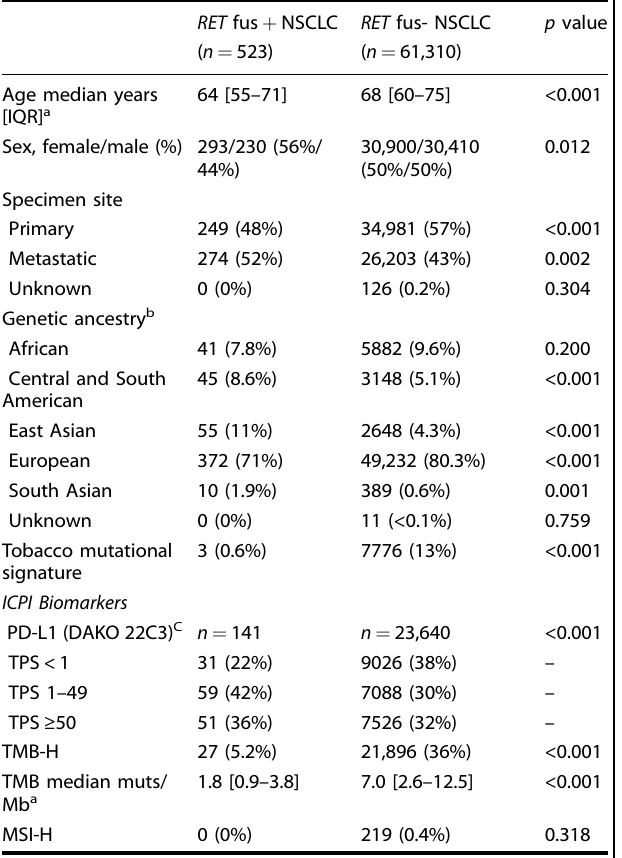
Table 2. Clinicopathologic and genomic biomarker characteristics comparing RET fusion-positive NSCLC and RET fusion-negative NSCLC.